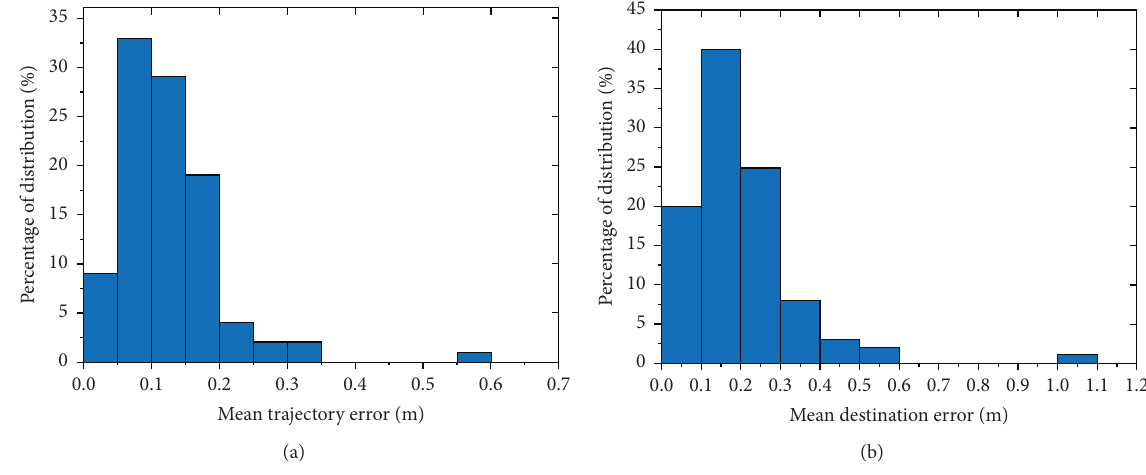
Figure 12: MTE frequency and MDE frequency of the unidirectional flow scenario. (a) MTE frequency. (b) MDE frequency.